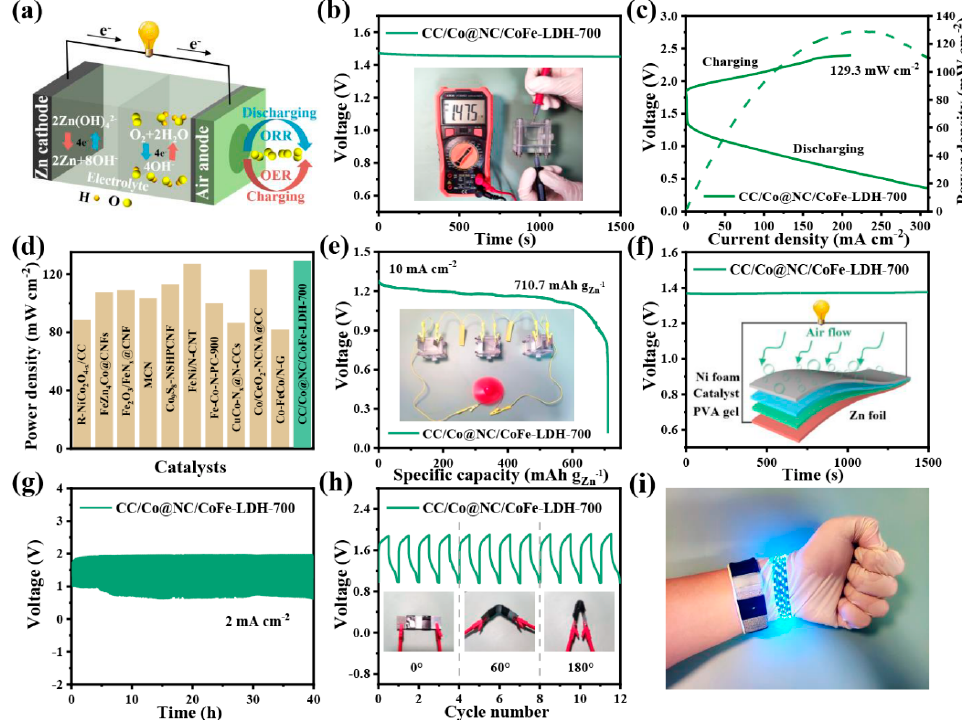
Figure 6. Electrochemical performance of ZABs with CC/Co@NC/CoFe-LDH-700 as the air cathode. ( a ) Schematic diagram of a liquid ZAB. ( b ) Open-circuit voltage measurement of the liquid ZAB. ( c ) Charge-discharge polarization curves and corresponding power density plot. ( d ) Performance comparison of liquid ZABs based on different air cathodes . ( e ) Specific capacity curve. ( f ) The open-circuit plot and the inset show a schematic illustration of a solid-state ZAB. ( g ) Galvanostatic cycling curve at 2 mA cm − 2 . ( h ) Cycling stability under different bending angles. ( i ) Photograph shows the application of wearable and flexible ZABs.